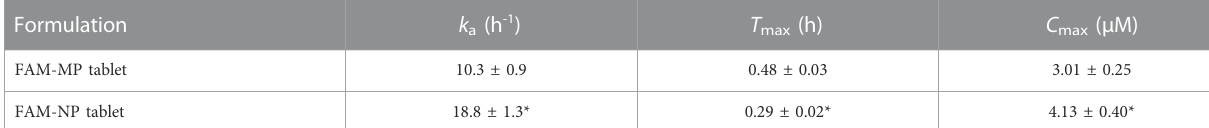
TABLE4TheFAM-MPandFAM-NPtables(Rp.9formulation)showninTable1wereusedinthisstudy(n=3).Thekewas7.8×10 − 2 h − 1 .n=6 – 7.*p < 0.05vs.FAM-MP tablet for each category.